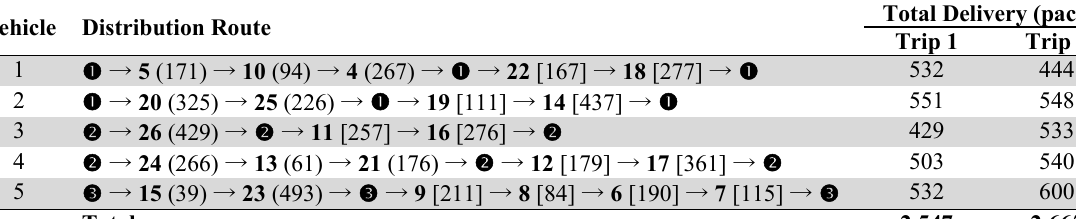
Distribution route and delivery of period 5